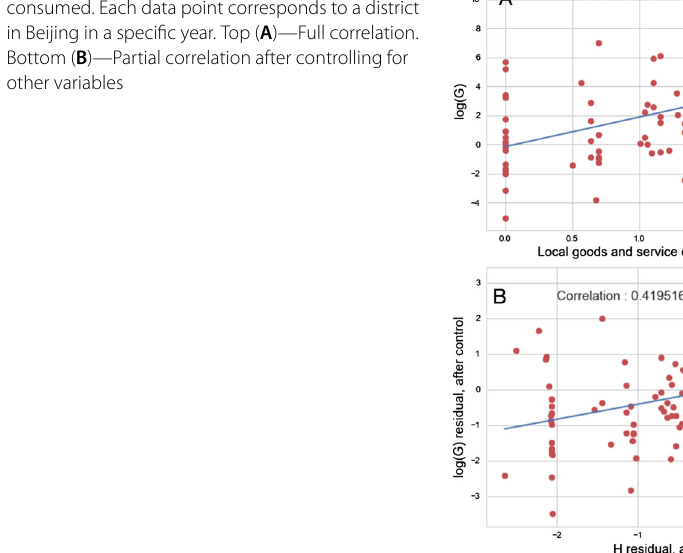
Figure 5 Scatter plot of growth vs diversity of goods consumed. Each data point corresponds to a district in Beijing in a specific year. Top ( A )—Full correlation. Bottom ( B )—Partial correlation after controlling for